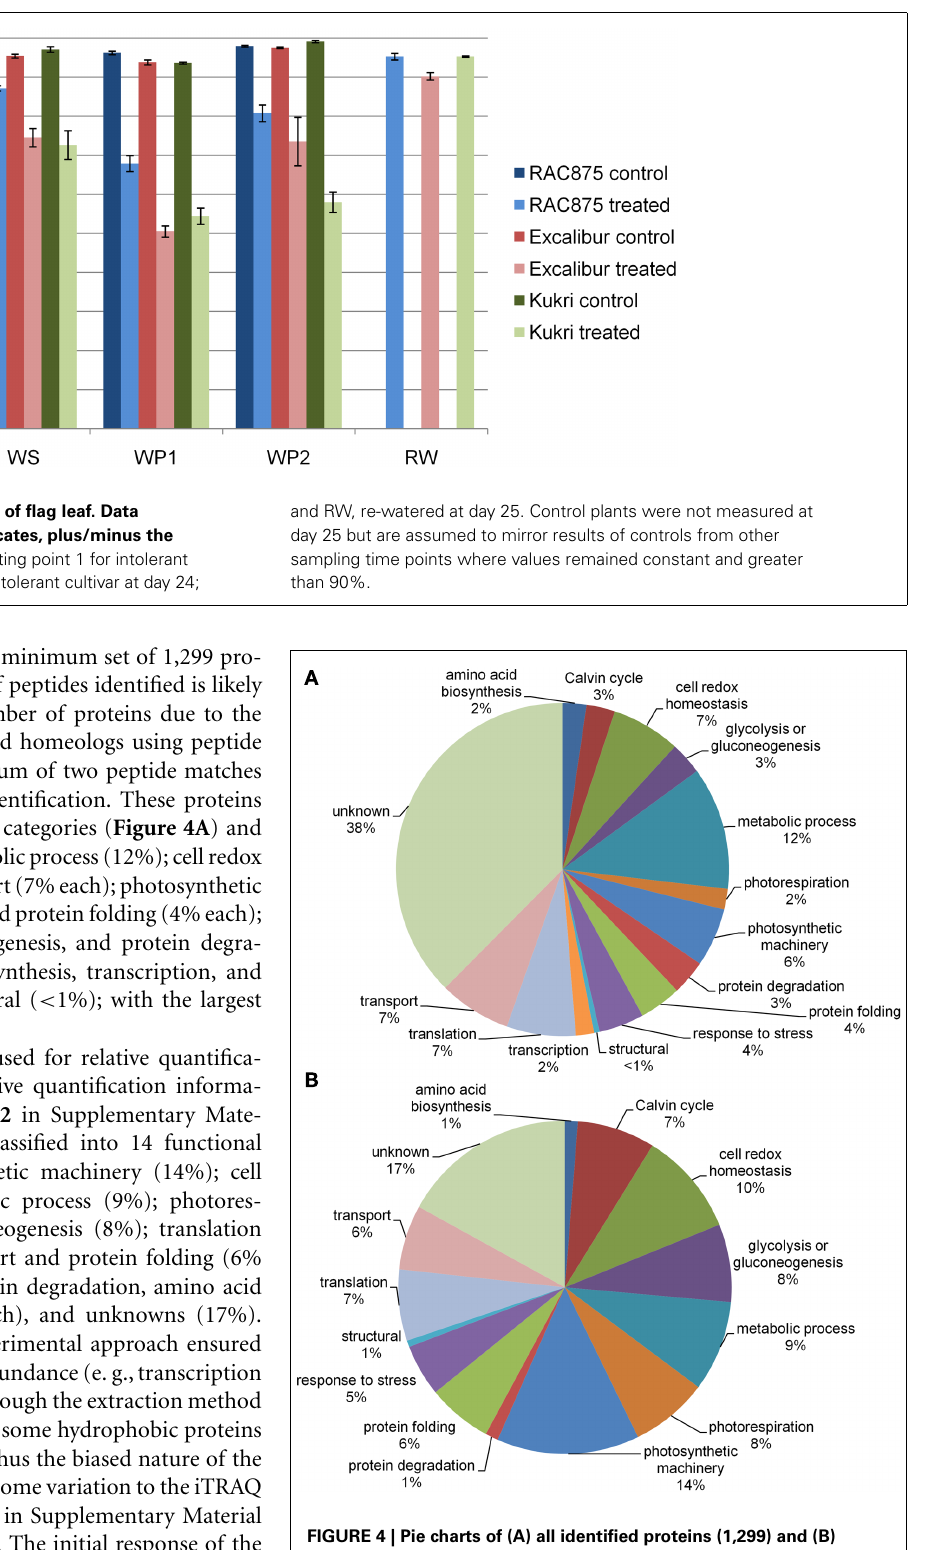
FIGURE 4 | Pie charts of (A) all identified proteins (1,299) and (B) proteins with iTRAQ data (159) divided into functional